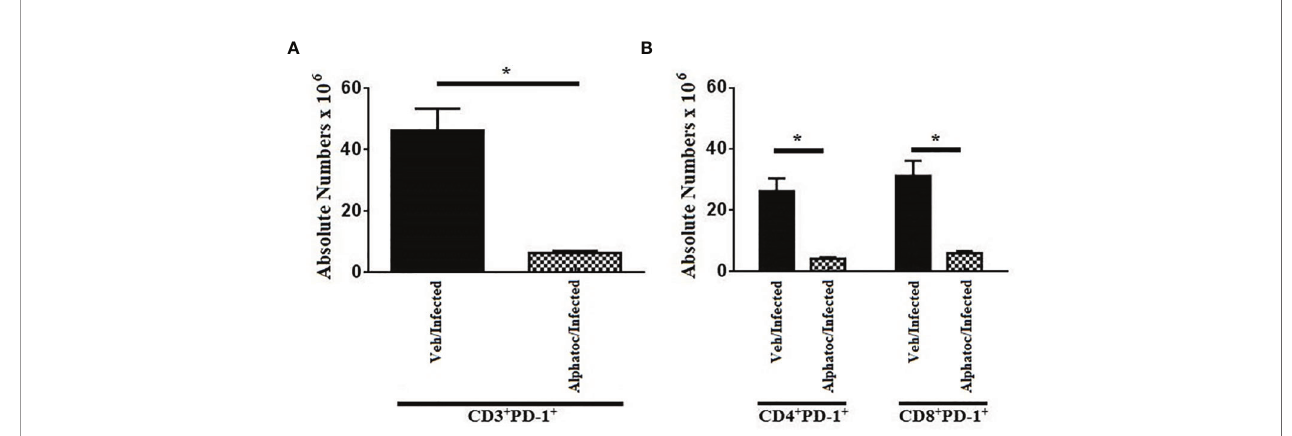
FIGURE 4 | PD-1 expression in CD3 + , CD4 + and CD8 + splenic T cells from animals on day 60 th after infection with 10 3 forms. In (A) , absolute numbers of CD3 + PD1 + are shown. In (B) , total numbers of CD4 + PD1 + and CD8 + PD1 + T cells are depicted. Groups of mice pretreated with vehicle or alphatoc were infected and individually compared after 60 days (*P < 0,05, Mann Whitney test, n= 4). A third untreated group was used as a control. Data are for one representative experiment out of